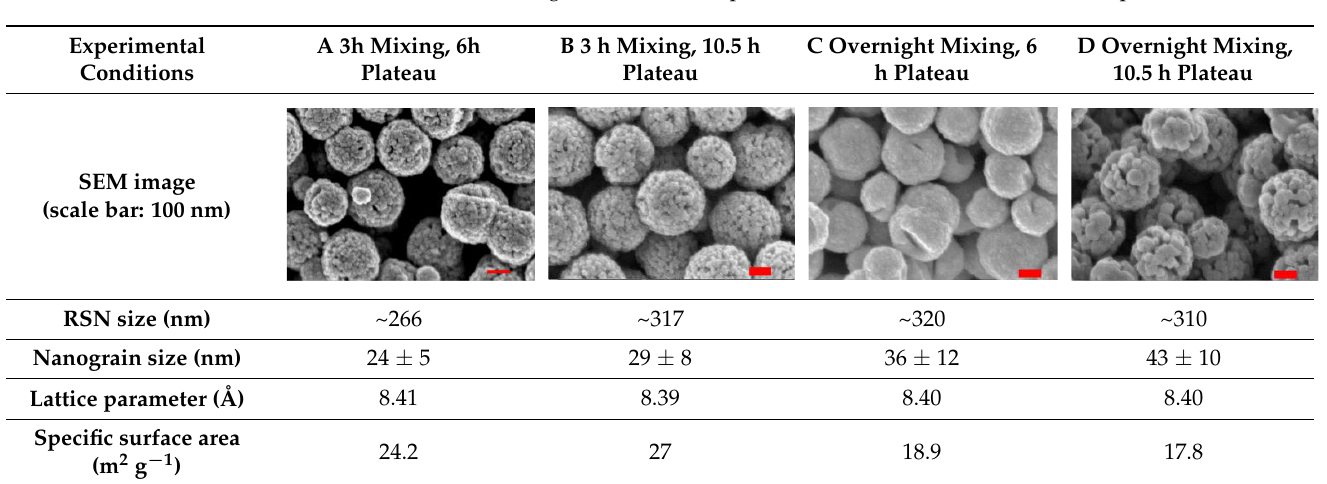
Table 5. RSN synthesis of experiments A, B, C, and D with 3 or 24 h of mixing and 6 or 10.5 h of reaction time at the highest reaction temperature (standard deviation for lattice parameter: ±0.01).